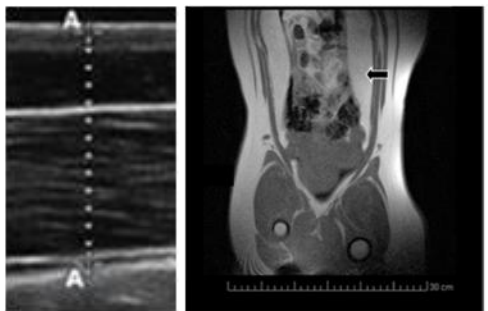
Figure 3. Imaging of subcutaneous fat depth by ultrasonography (left hand) and visceral fat depots by magnetic resonance imaging (MRI; right hand; black arrow).